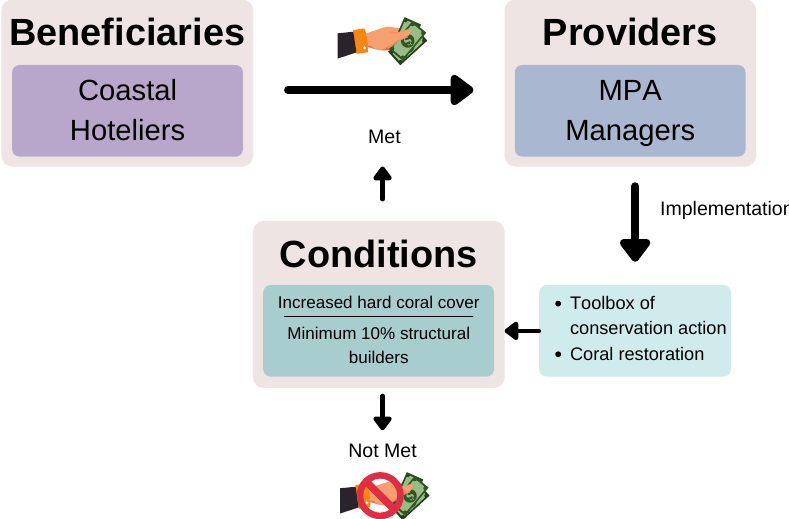
Figure 1. Potential PES mechanism to improve coastal